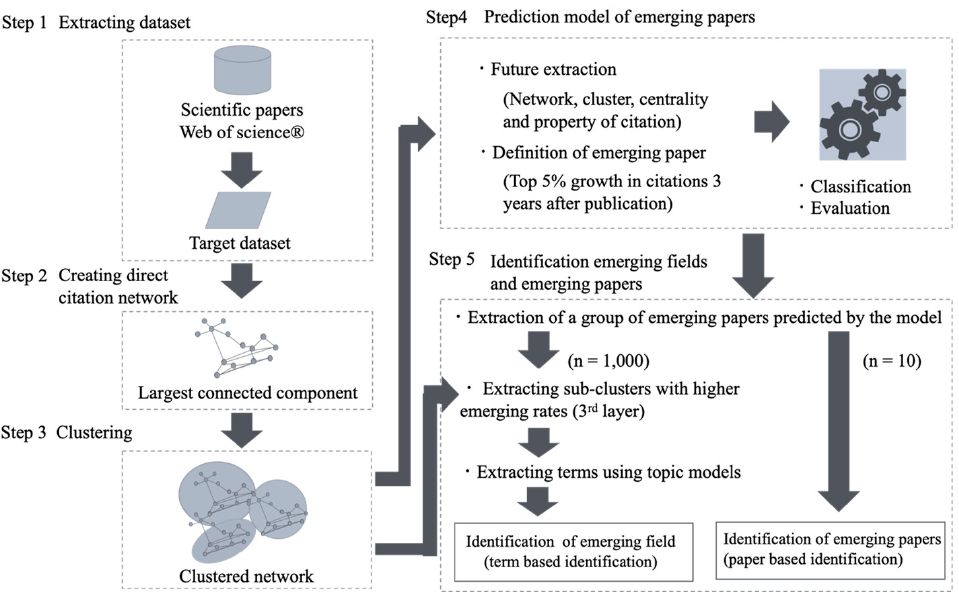
Figure 1. Overview of the method.